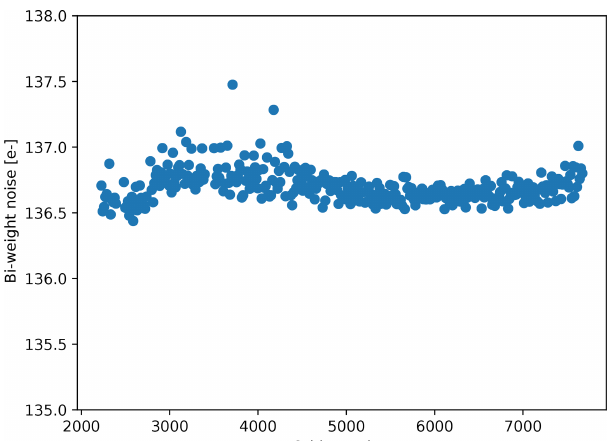
Figure 21. Median noise as a function of time. Large instabilities have been removed from this trend. Note that the median noise is insensitive to cosmic-ray impacts.